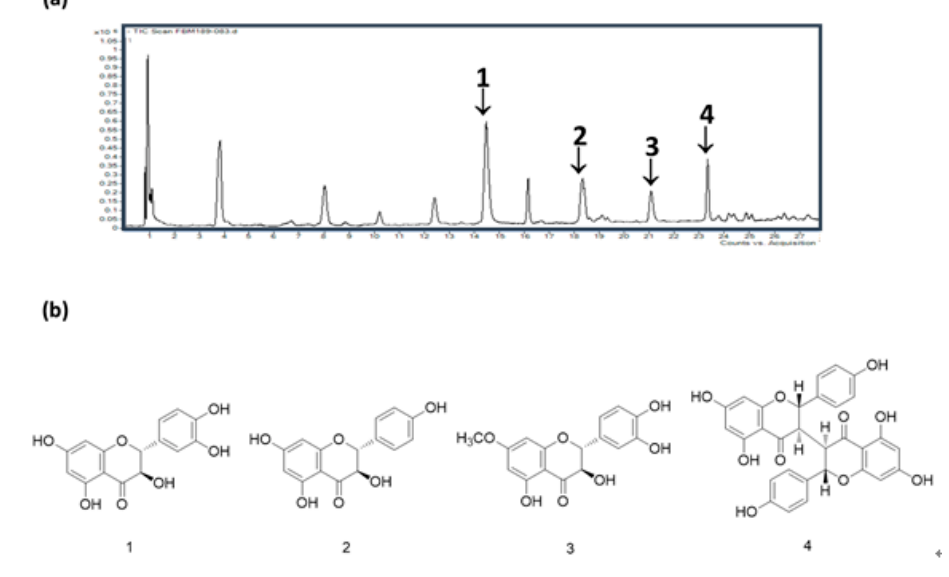
Figure 6. ( a ) HPLC/MS chromatogram of WDE. ( b ) Chemical structures of its major components. Fingerprint analysis of WDE was performed in positive ion mode by HPLC/MS. 1: taxifolin, 2: